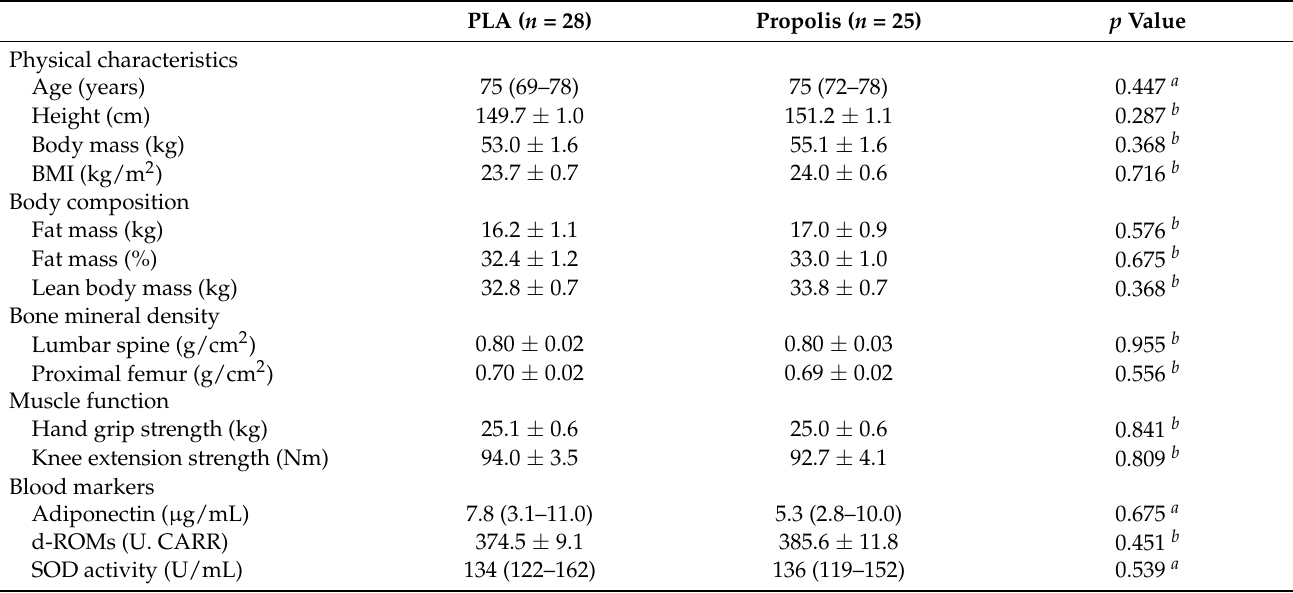
Table 1. Baseline characteristics of the participants in each